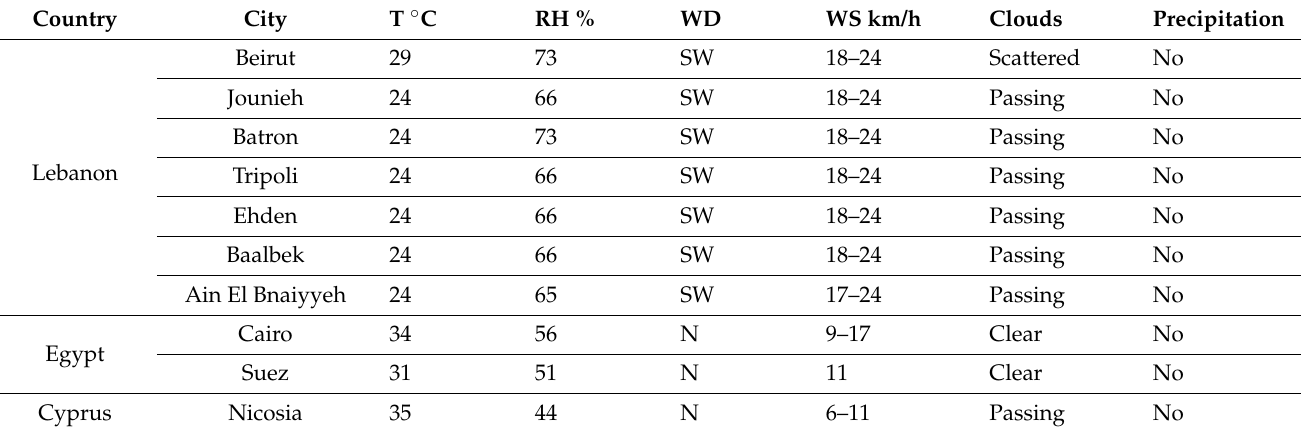
Table 2. Weather conditions in Beirut, Jounieh, Tripoli, Ehden, Baalbek, Cairo, Suez, and Nicosia during the study period are displayed in Table 2. Weather information is not available for Batorn and Ain El Bnaiyyeh in